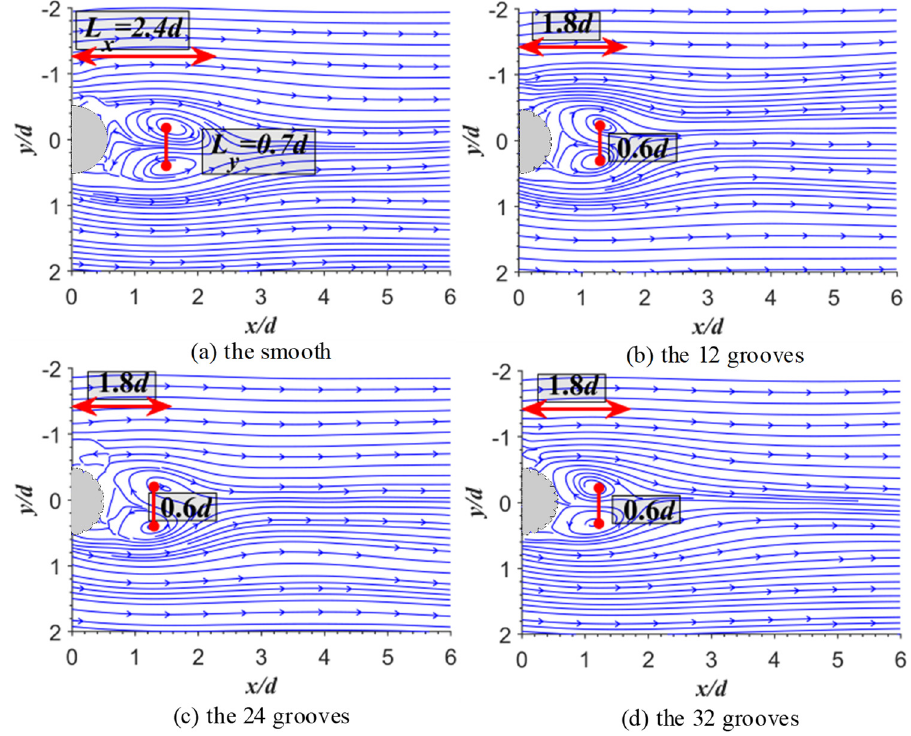
Figure 6. Time-averaged streamlines in the ( x, y )-plane.